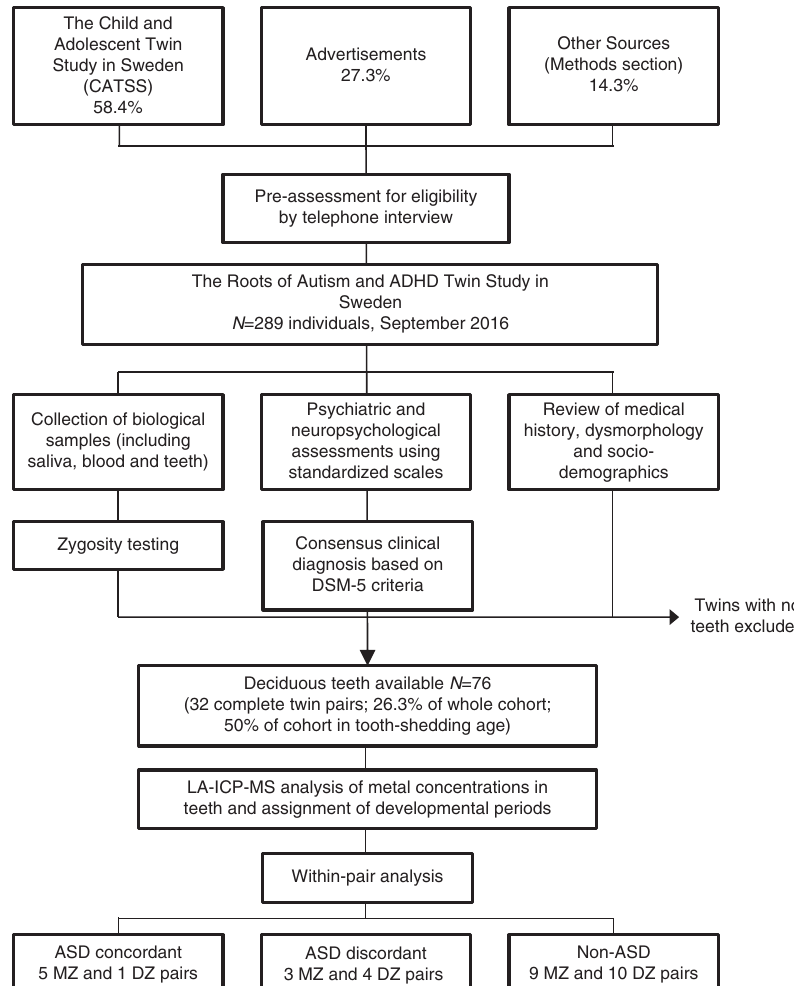
Figure 1 | Roots of Autism and ADHD Twin Study in Sweden (RATSS). Recruitment, case ascertainment and collection of teeth for measurement of metals.